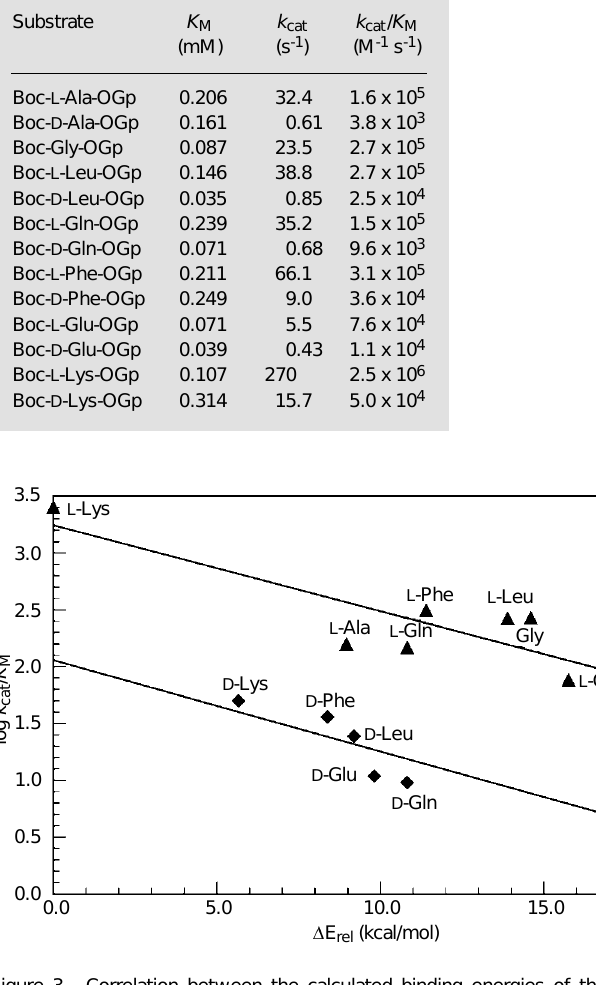
Figure 3 - Correlation between the calculated binding energies of the most stable productive complexes of Boc-Xaa-OGp and trypsin and the specificity constants of the hydrolysis reaction (25). The correlation coefficients are R = -0.84 for the L -series including Gly (triangles) and R = -0.91 (lozenges) for the D